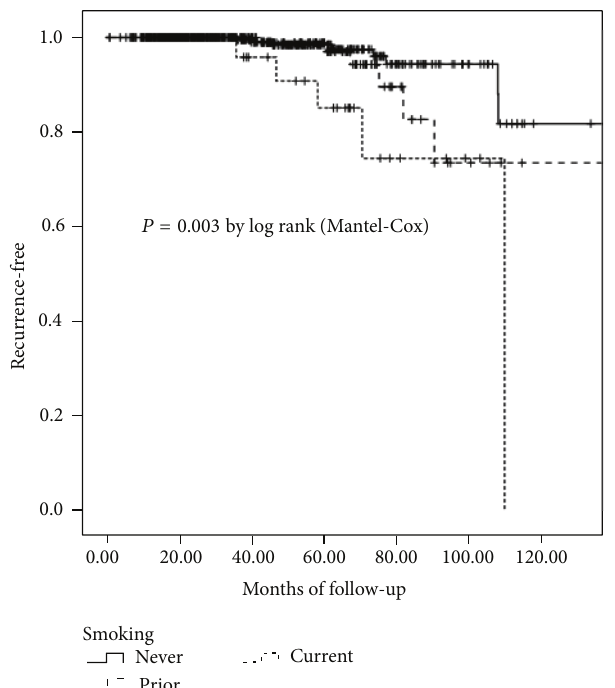
Figure 1: Kaplan-Meier plot of recurrence-free survival by smoking status.